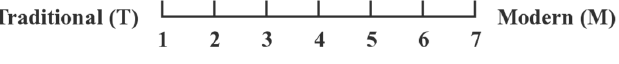
Figure 10. The seven-point Likert scale of T–M product image.